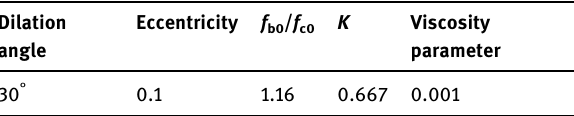
Table 1: Damage parameters for concrete with a normal strength [ 19 ] Dilation angle